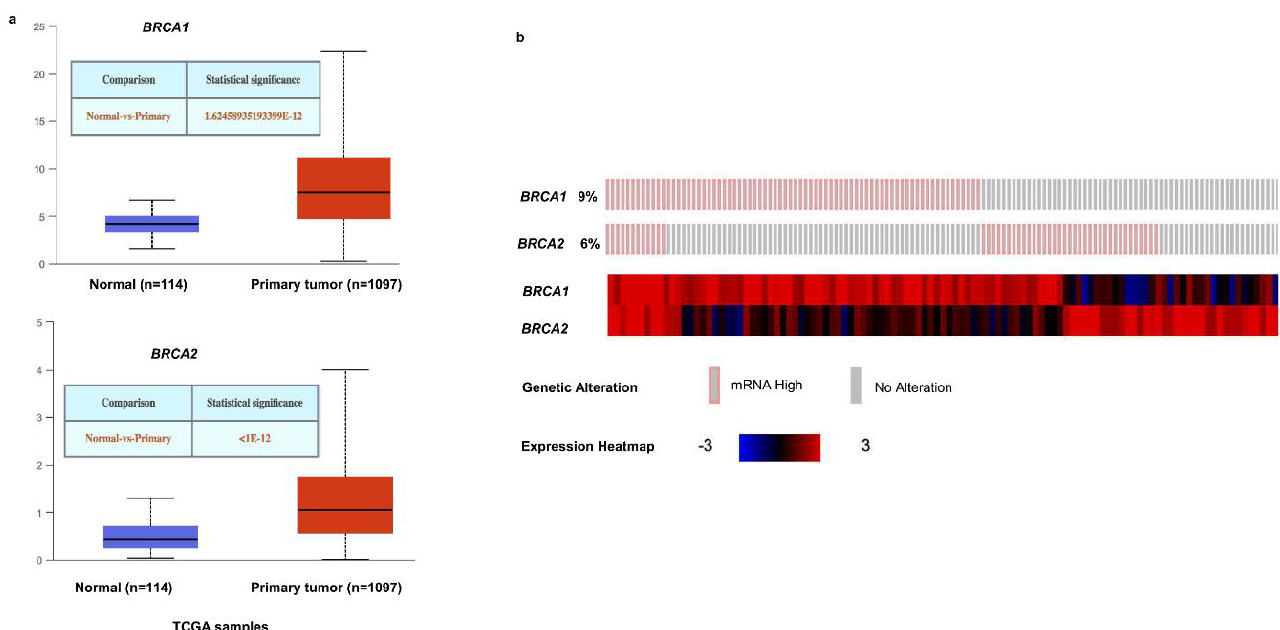
Figure 2. Expression of BRCA1/2 in BRCA patients. ( a ) Expression of BRCA1/2 in BRCA based on sample types by UALCAN (http://ualcan.path.uab.edu/index.html, accessed on 10 February 2022). ( b ) Expression of BRCA1/2 in BRCA by cBioPortal database (https://www.cbioportal.org, accessed on 10 February 2022) (breast invasive carcinoma (TCGA, Cell 2015)).